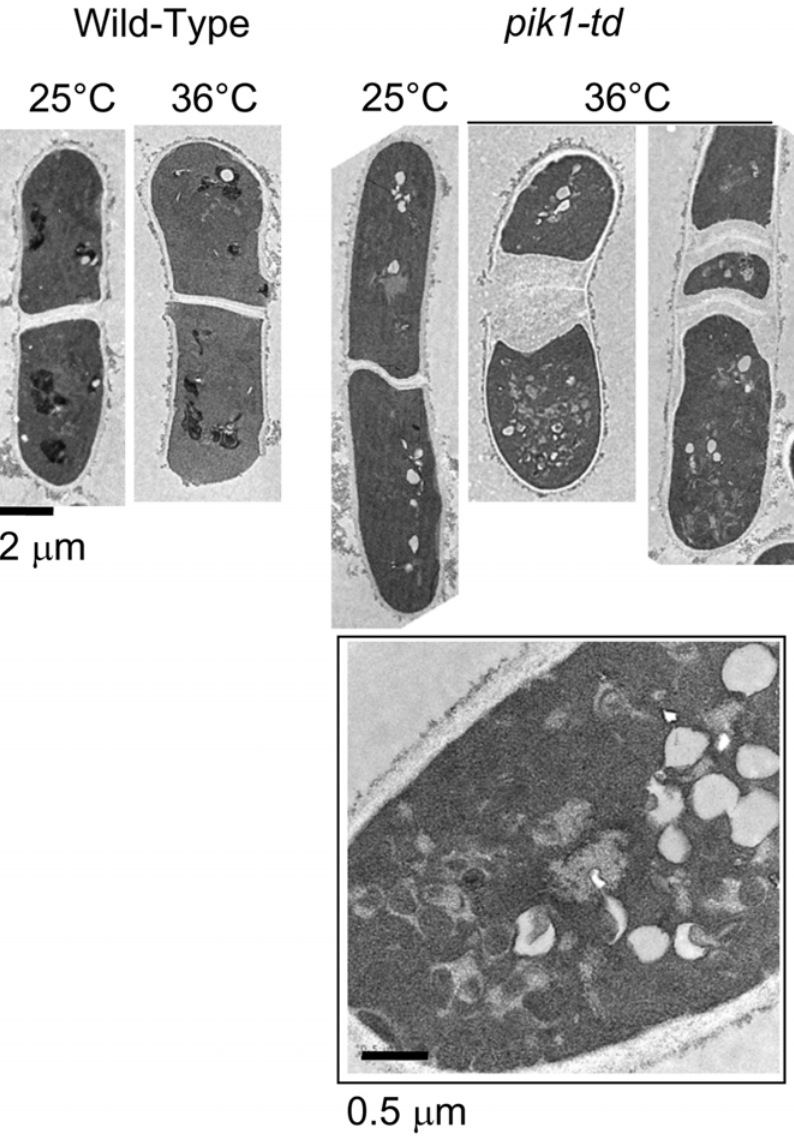
Figure 3. Septum morphology in pik1-td cells. Wild-type or pik1-td cells (N1366) were cultured for 18 h at 25 u C or 36 u C. Cells were fixed with potassium permanganate and processed for transmission electron microscopy. At 36 u C, there was one or more septum per cell. The secondary septum were thickened relative to septum in pik1-td cells at 25 u C or in wild-type cells at 25 u C or 36 u C. Intracellular membranous and vacuolar structures also accumulate in pik1-td cells at 36 u C (magnified